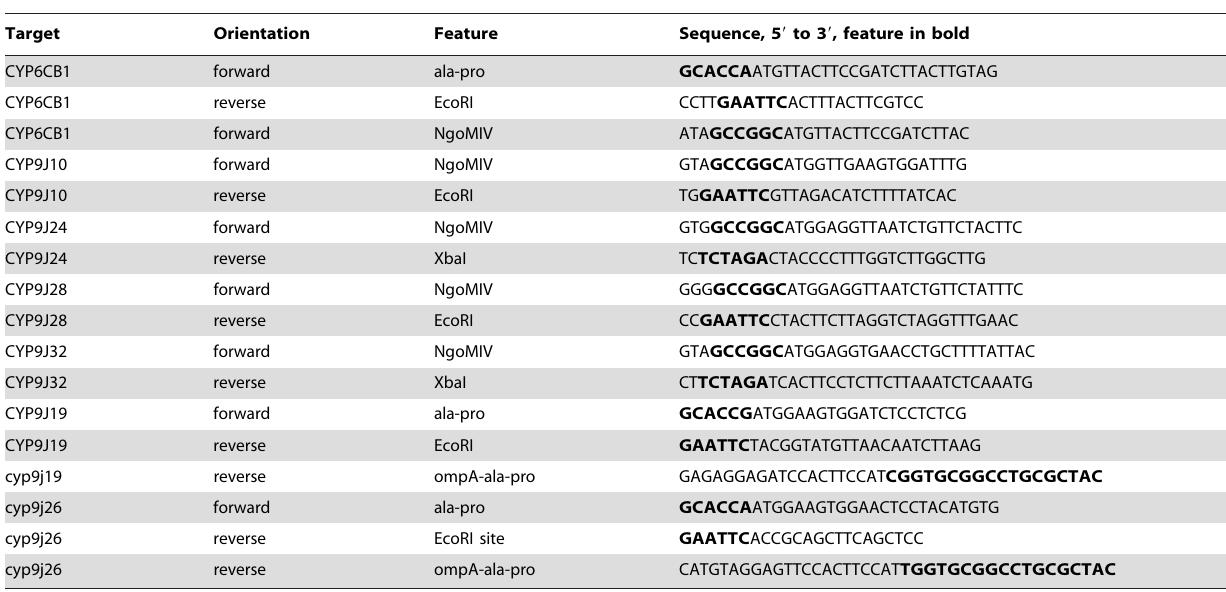
Table 2. Oligonucleotide sequences used for cloning Ae. aegypti P450 genes.